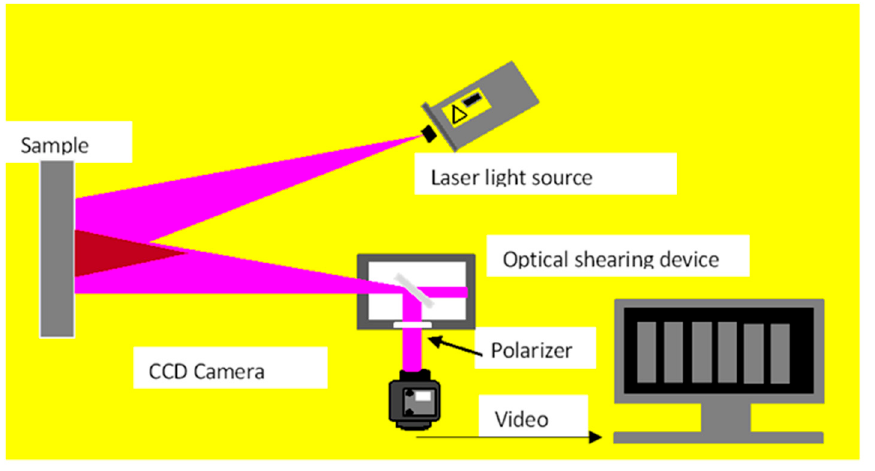
Figure 5. The basic setup of Laser